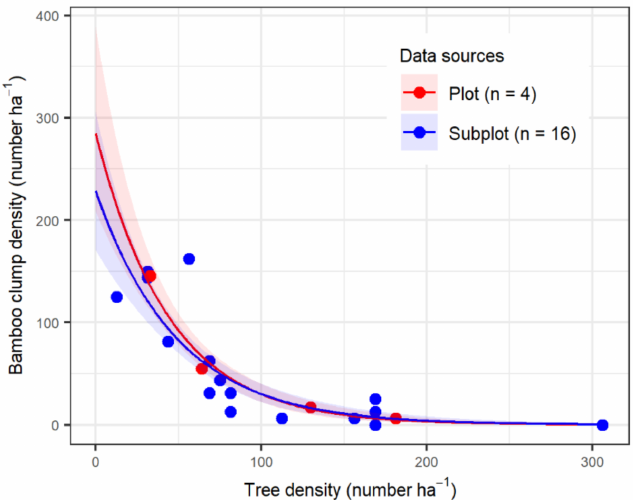
Figure 5. Relationships between tree density and bamboo clump density at the plot (n = 4) and subplot (n = 16) levels with prediction lines obtained from the Poisson generalized linear model (GLM) assuming that the area is 1